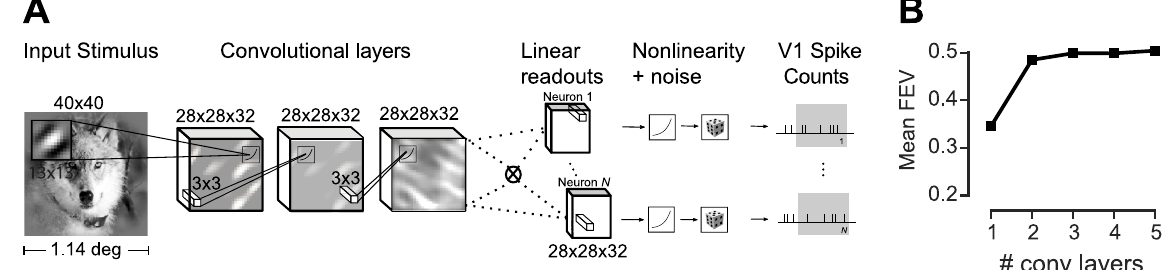
Fig 7. Data-driven convolutional network model. We trained a convolutional neural network to produce a feature space fed to a GLM-like model. In contrast to the VGG-based model, both feature space and readout weights are trained only on the neural data. A . Three-layer architecture with a factorized readout [40] used for comparison with other models. B . Performance of the data driven approach as a function of the number of convolutional layers on held-out data. Three convolutional layers provided the best performance on the validation set. See Methods for